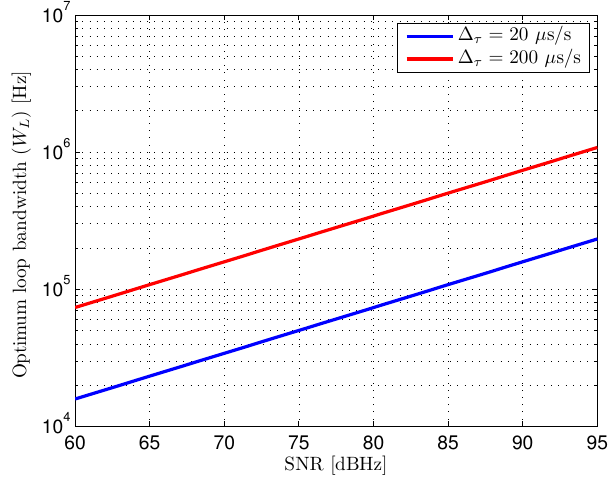
) that minimizes the total error ( (cid:15) L ) τ